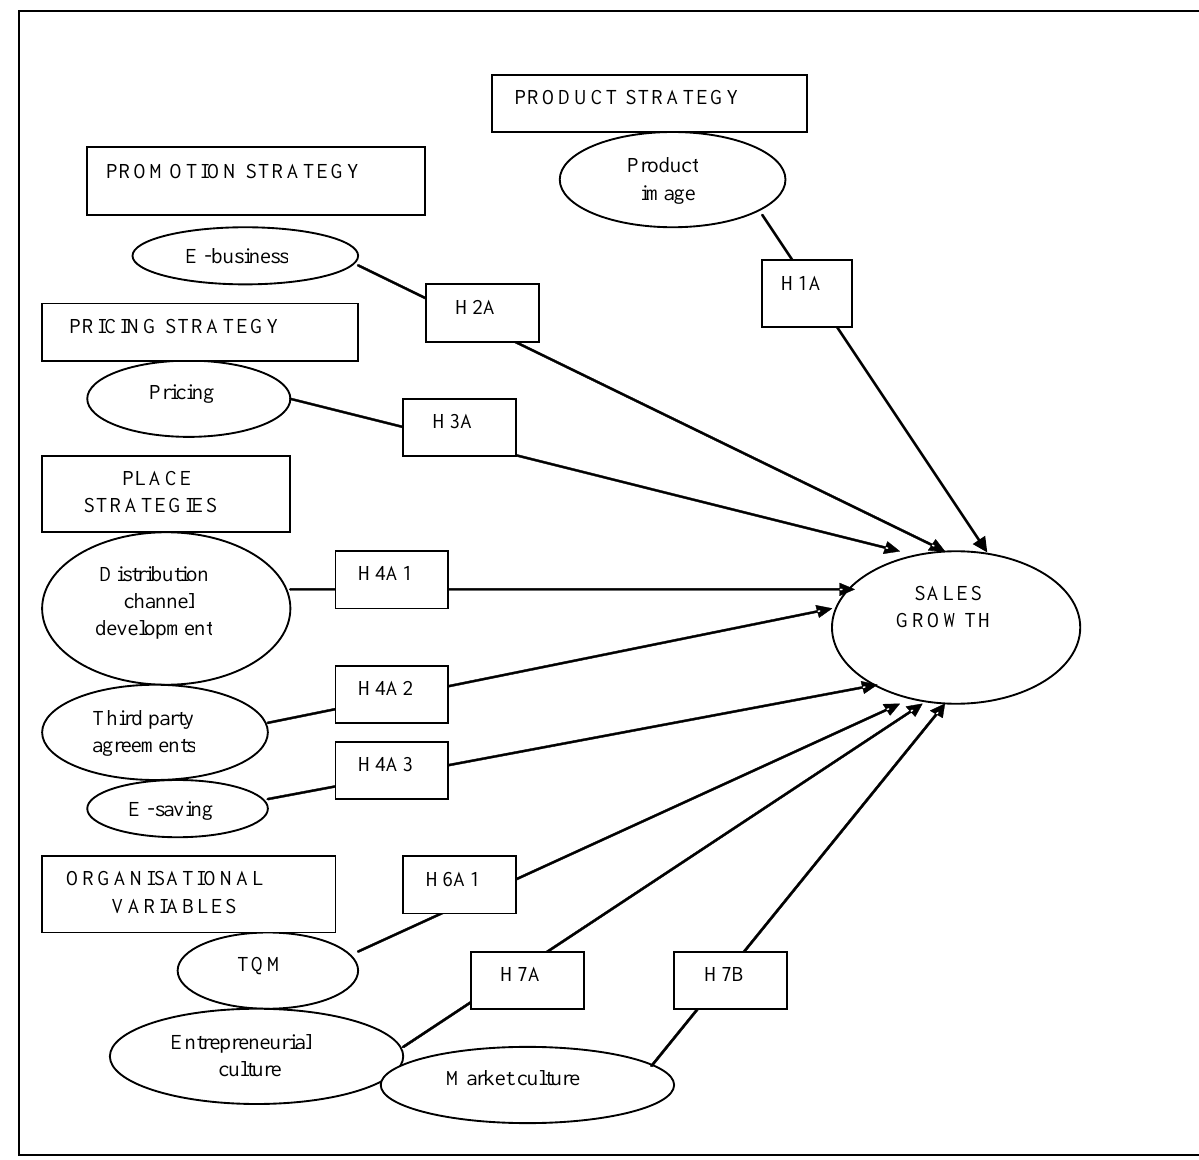
Figure 2: the revised hypothesised